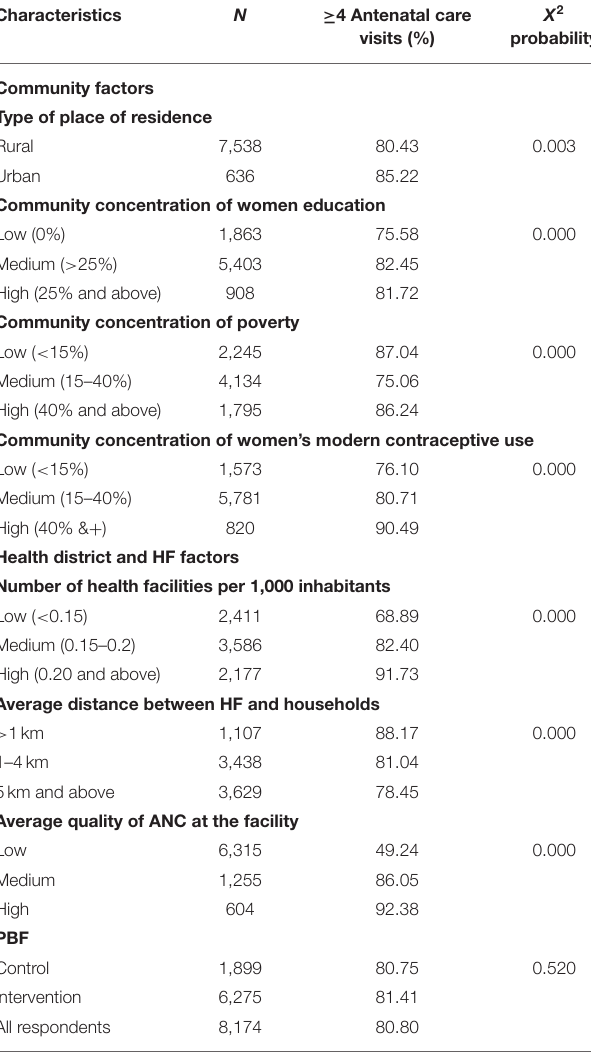
TABLE 3 | Variations in indicators of the use of ANC visits, by selected community and districts characteristics.